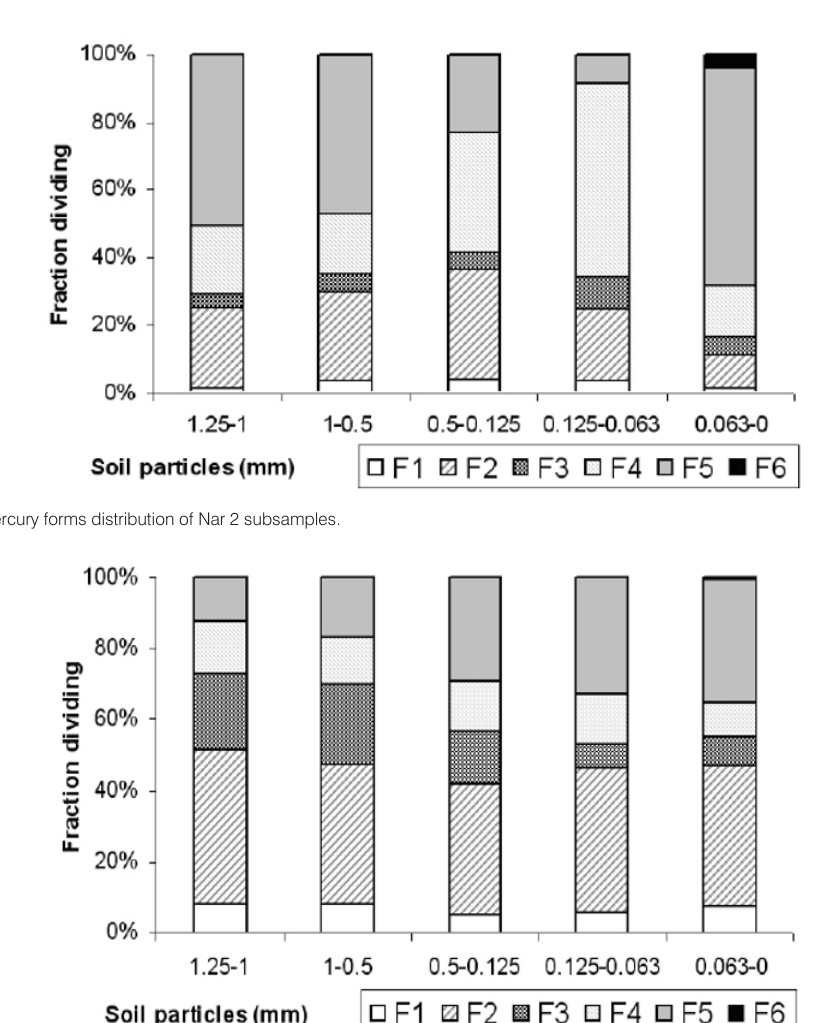
Figure 2. Mercury forms distribution of Bor 5